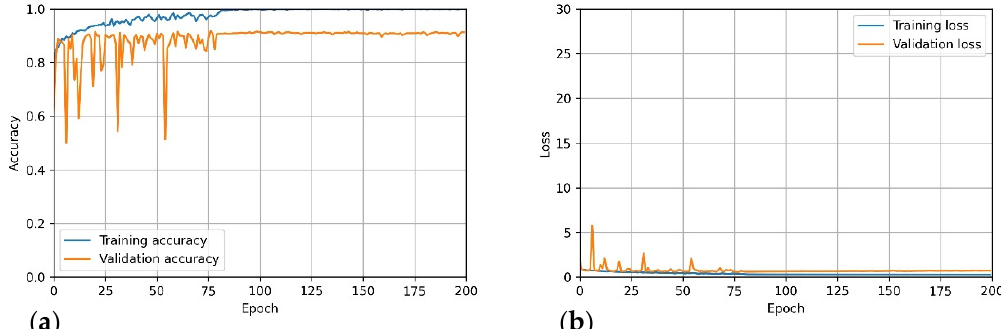
Figure 10. Unthresholded recurrence plot by chaos and non-chaos (chaos: [1 0], non-chaos: [0 1]).